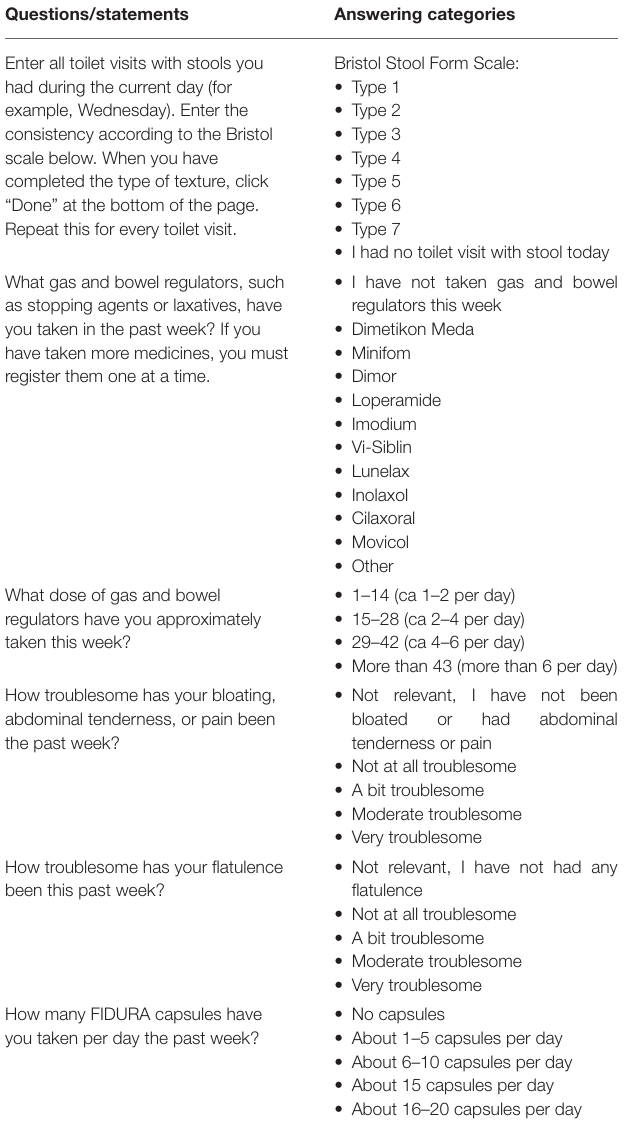
TABLE 1 | Questions, statements, and answering categories used in the